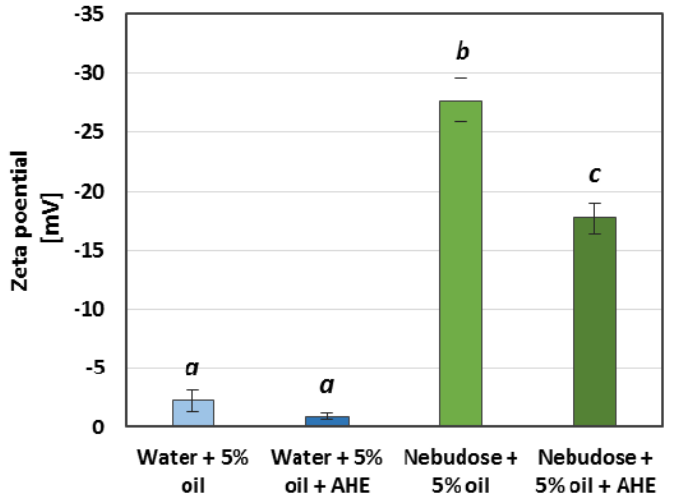
Figure 4. Zeta potential values of the tested emulsions’ droplets. AHE was applied in the final concentration of 2 g/L. Small italicized letters indicate the statistical differences between the data series.